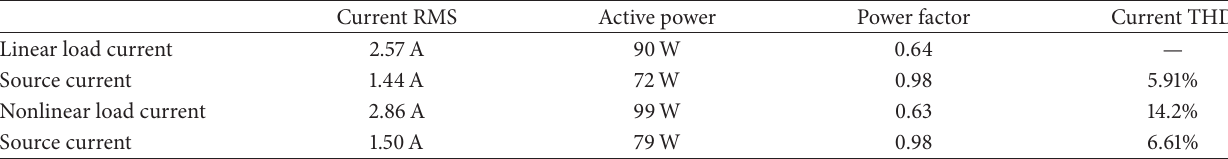
Table 6: Experimental results of capacitive-coupling